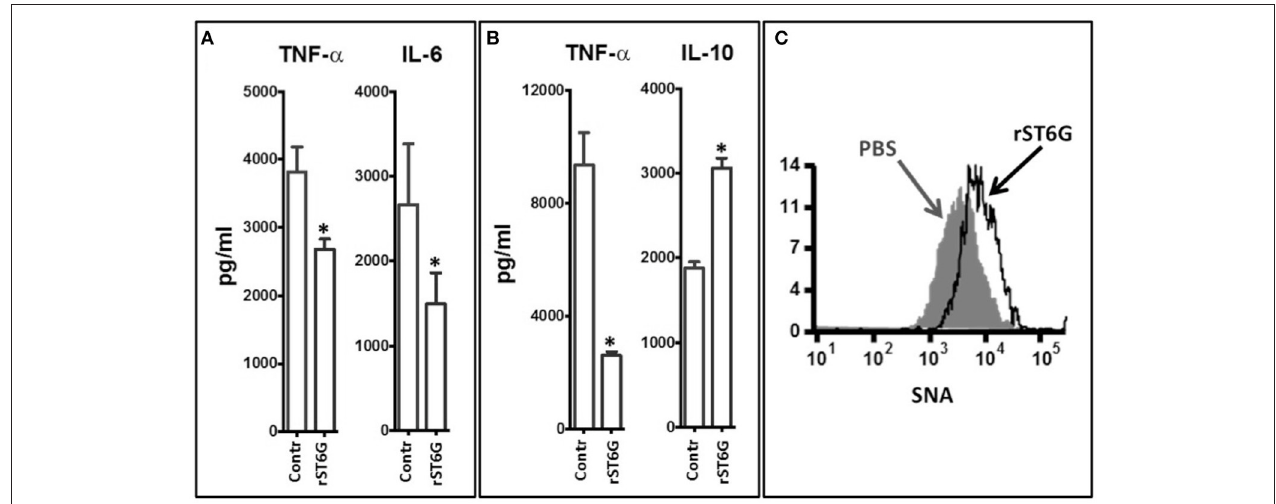
FIGURE 6 | Inflammatory cytokine release by macrophage was attenuated by ST6Gal-1. (A) Macrophages were recovered from the BALF of 3 wild-type C57BL/6 mice (at rest). The pooled cells were plated into 5 replicate but identical wells for each determination. Groups of 5 macrophage wells were exposed ex vivo to 10 5 CFU/ml heat-killed NTHI either in the absence or presence (20 µ g/ml) of rST6G and CMP-Sia (100 µ M) for 18h. TNF- α and IL-6 released into the media was measured next day. * p < 0.001. (B) Bone marrow–derived macrophages were generated from marrow cells of C57BL/6 WT animals. The identically seeded cells, in groups of 5 wells per treatment, were exposed to heat-killed NTHI in the absence (control) or presence of rST6G (20 µ g/ml) and CMP-Sia (100 µ M) and incubated overnight (37 ◦ C and 5% CO 2 ). TNF- α and IL-10 released into the media were assessed by ELISA. * p < 0.001 based on concentration values from five separate wells for each condition. All data are representative of six separate experiments. (C) BALF macrophage was recovered from C57BL/6 WT animals 18h after oropharyngeal challenge with NTHI using the protocol in Figure 4A , either with rST6G (rST6G) or sham (PBS). Cell surface sialylation was measured using the α 2,6-sialic acid-specific lectin, FITC conjugated Sambucus nigra agglutinin (SNA) by flow cytometry, as